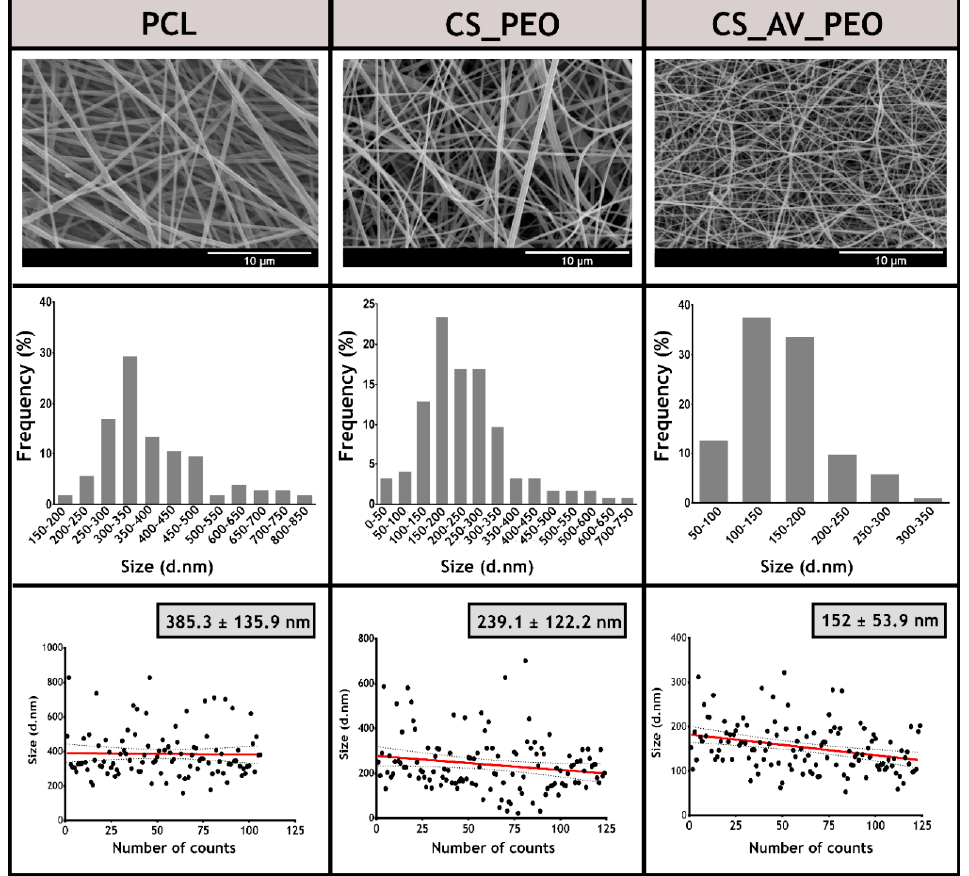
Figure 2. Characterization of the morphologic features of the produced asymmetric membranes. SEM images, fiber diameters distribution and the diameters of different fibers of the top layer (PCL) and bottom layers (CS_PEO or CS_AV_PEO) of the produced bilayer membranes are presented.